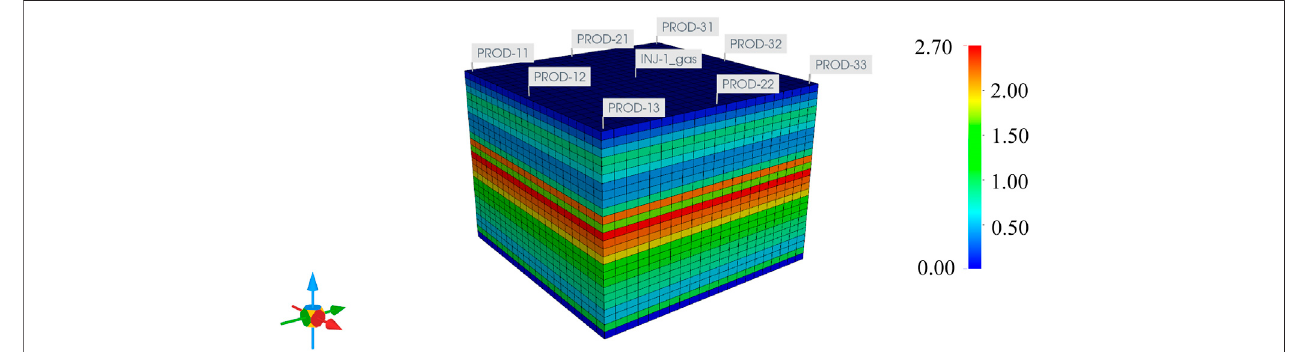
FIGURE 1 | Permeability model.